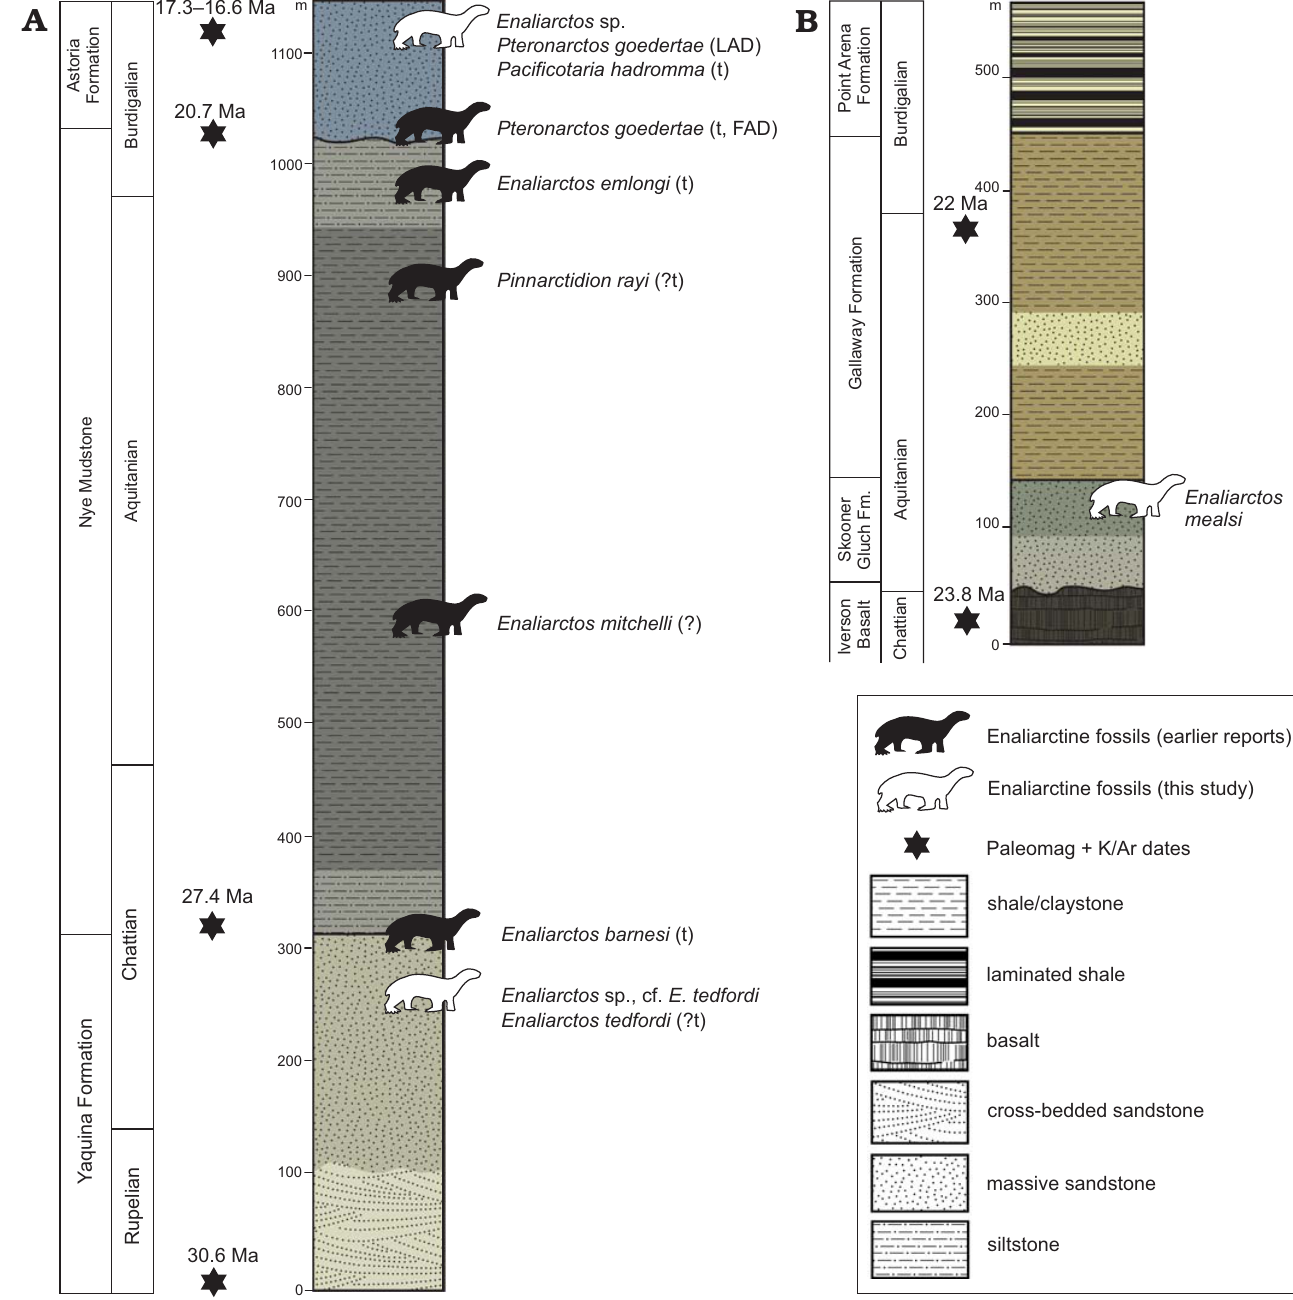
Fig. 2. Stratigraphic columns of Oregon ( A ) and California ( B ) localities. Columns based on Snavely et al. (1964) and Phillips et al. (1976); paleomagnetic and K/Ar dates from Prothero et al. (2001a, b) and Phillips et al. (1976). In the interest of clarity non-enaliarctine marine carnivores are omitted. Modified from Moore (1963) and Phillips et al. (1976). Abbreviations: FAD, first appearance datum; LAD, last appearance datum; t, type